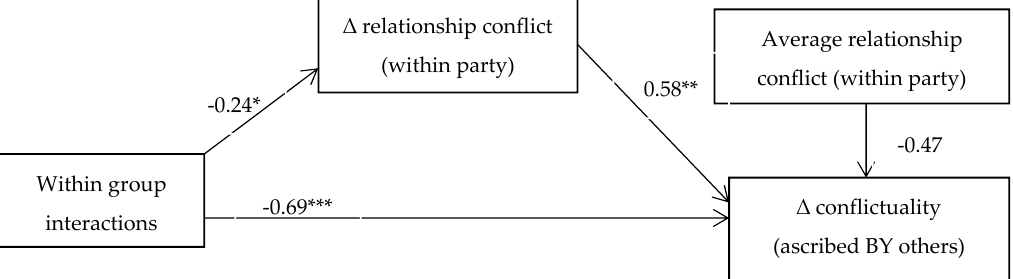
Figure 2. The overall mediation model for change in relationship conflict and conflictuality (bottom-up influence). Notes: * p < 0.05; ** p < 0.01, *** p < 0.001, Δ relationship conflict = relationship conflict at